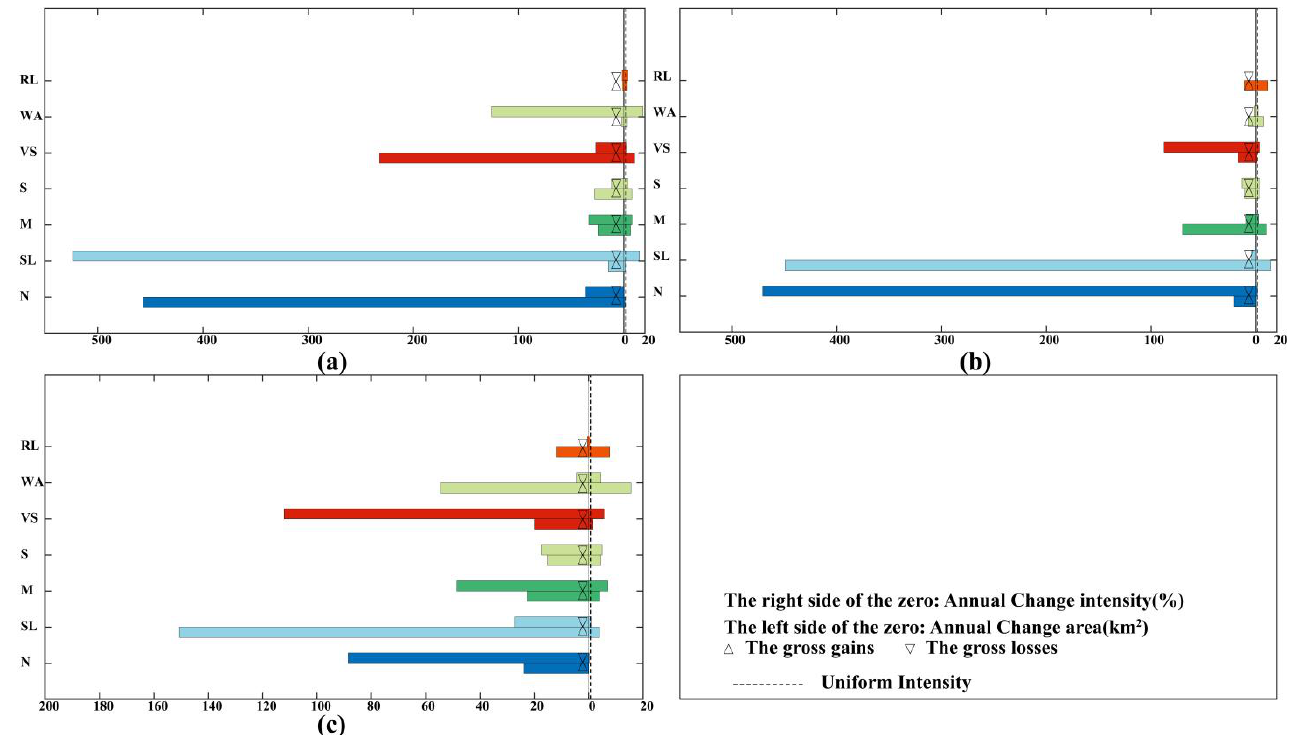
Figure 5. Area and intensity changes for different types of land in the East Ujimqin Banner. ( a ) The interval of 2000~2005; ( b ) the interval of 2005~2010; ( c ) the interval of 2010~2015.